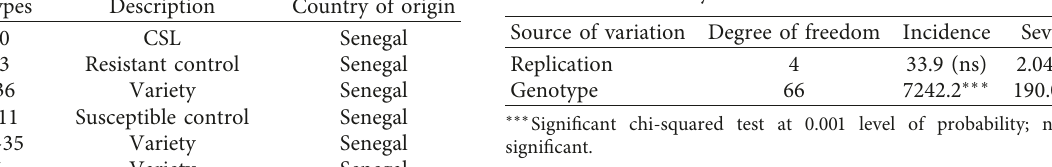
Table 2: Deviance values from the Poisson regression model on incidence and